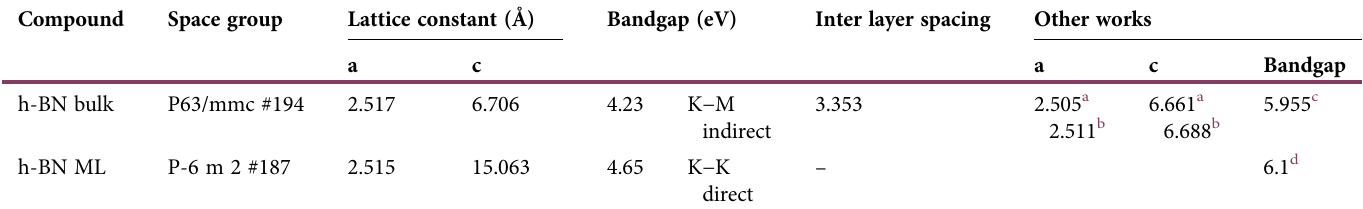
Table 1 Structural and electronic properties of the relaxed h-BN.